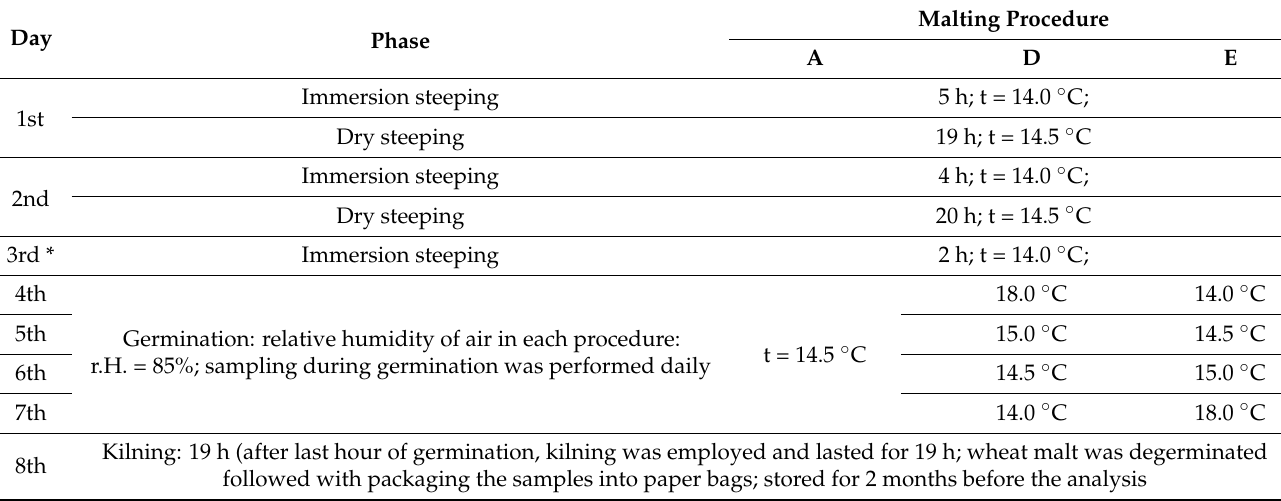
Table 2. The applied micromalting scheme of wheat